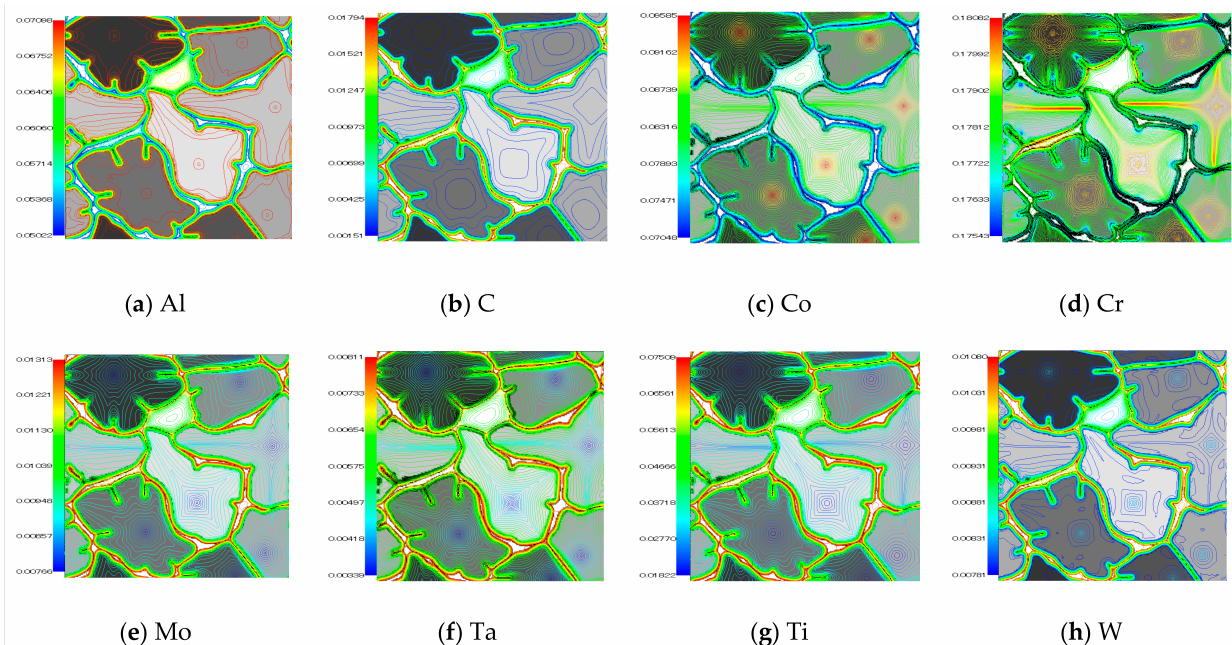
Figure 2. Solute concentration and γ grain distributions obtained by the quasi-equilibrium MPFM at 0.06 ms at a cooling rate of 10 5 K/s. ( a – h ) are Al, C, Co, Cr, Mo, Ta, Ti and W molar fractions,